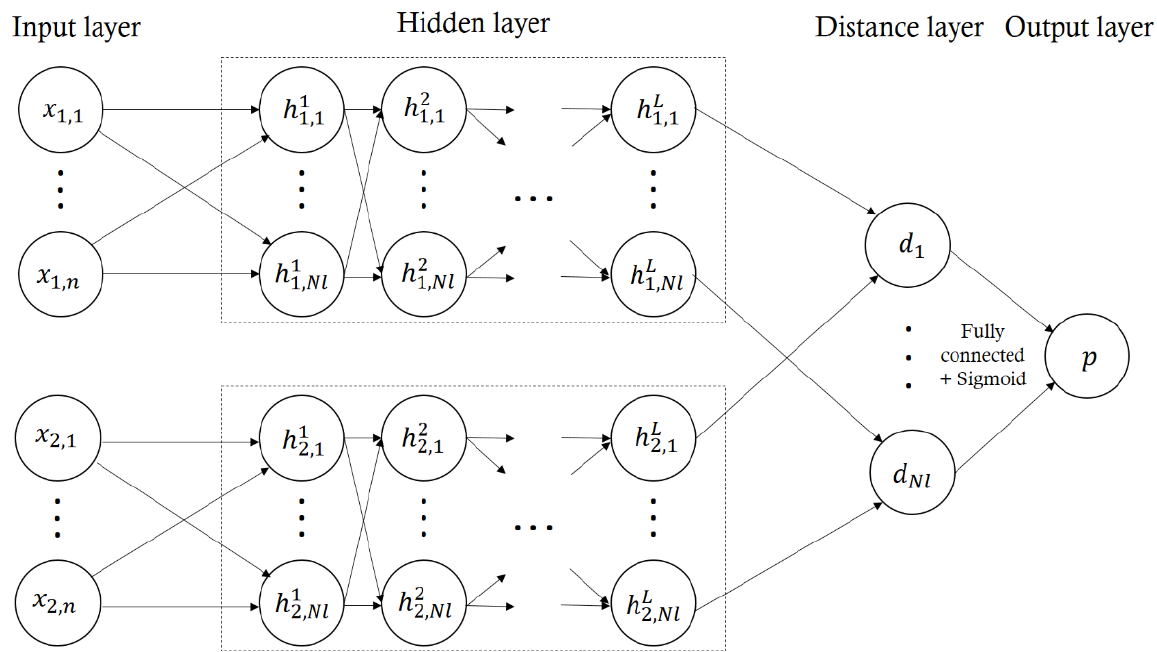
Figure 2. An architecture of simple L hidden layers of Siamese network for binary classification. In the twin networks, the weight matrices are shared at each layer [24].